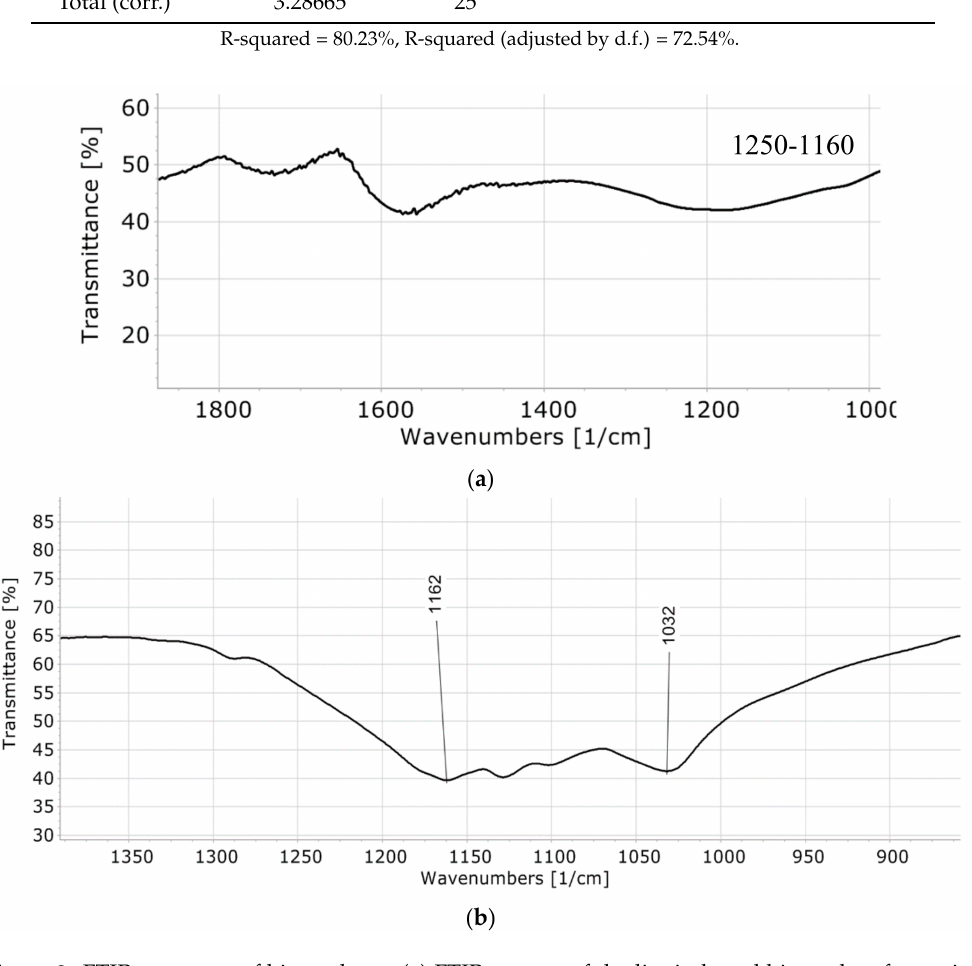
Figure 2. FTIR spectrum of biocatalysts. ( a ) FTIR spectra of the lignin-based biocatalyst from pine sawdust; ( b ) FTIR spectra of the lignin-based biocatalyst from processed wheat